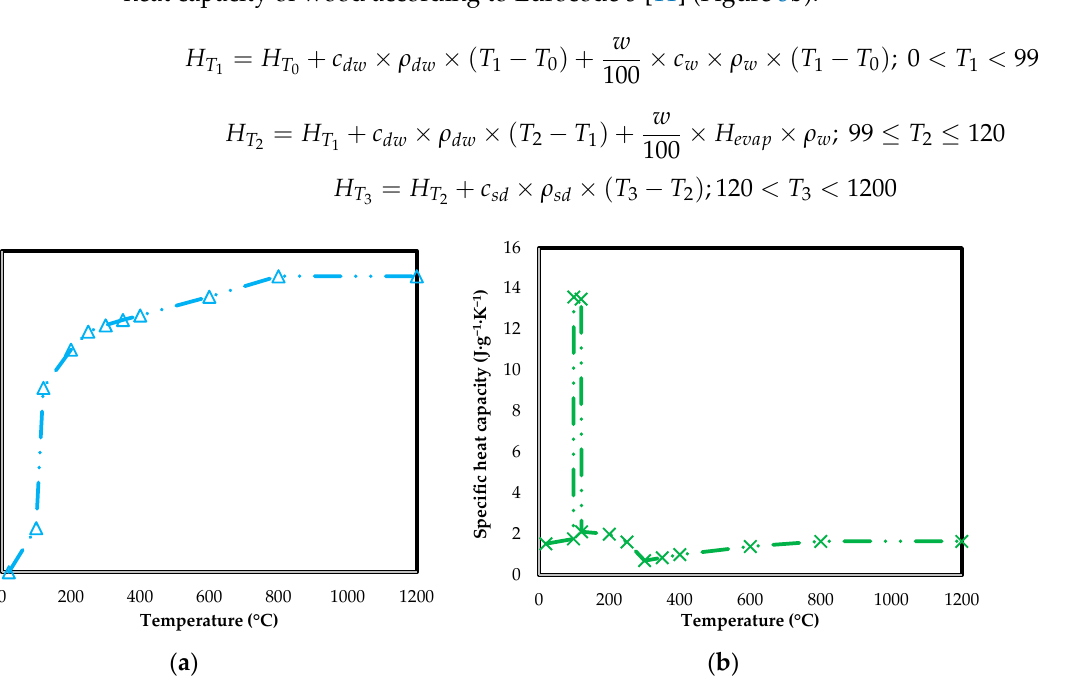
Figure 5. Properties of Norway spruce: ( a ) enthalpy; ( b ) specific heat capacity.